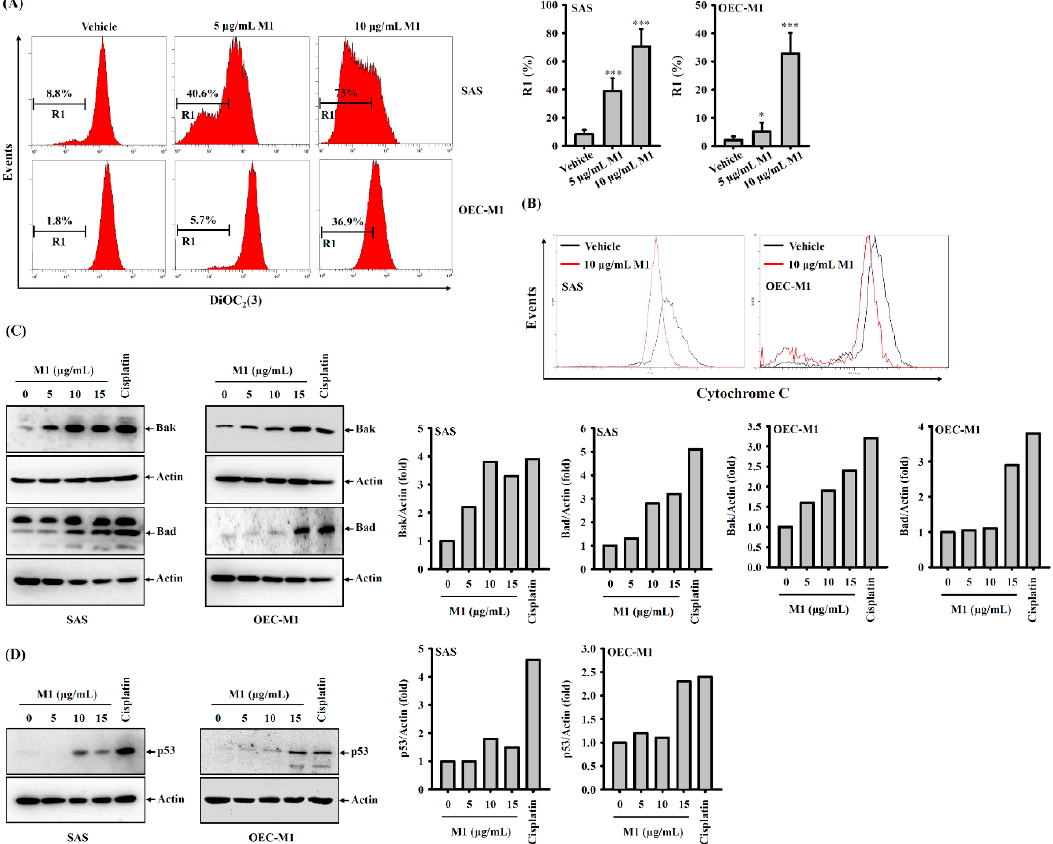
Figure 5. Ginsenoside M1 induced mitochondrial death pathway. SAS cells and OEC-M1 cells were incubated for 24 h with ginsenoside M1, 50 µM cisplatin, or vehicle. The mitochondria membrane potential was analyzed by DiOC 2 (3) staining ( A ). The release of mitochondrial cytochrome c was measured by flow cytometry ( B ). The expression levels of Bak and Bad ( C ) and p53 ( D ) were analyzed by Western blotting. * and *** indicate a significant difference at the level of p < 0.05 and p < 0.001, respectively, compared to vehicle-control cells. (One-way ANOVA with Dunnett’s multiple comparisons test).